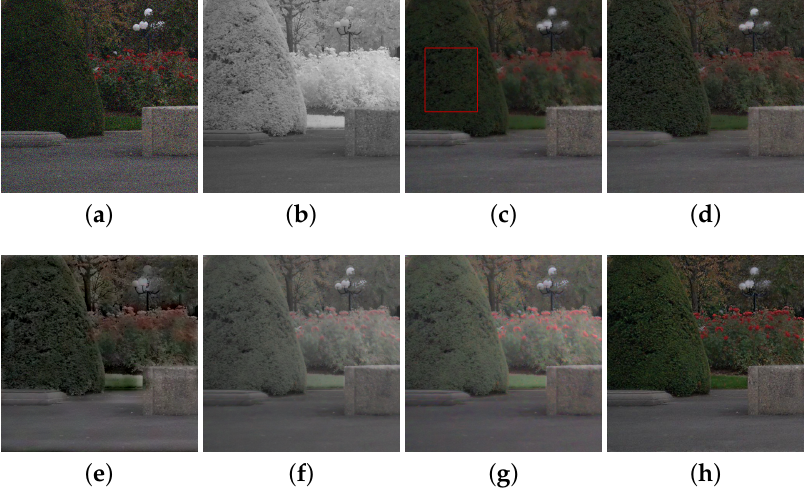
Figure 12. Experimental results for a test image. ( a ) Noisy RGB image. ( b ) NIR image. ( c ) DWLS [11]. ( d ) SM [8]. ( e ) GWS [1]. ( f ) DenseFuse [17]. ( g ) UDIF [20]. ( h ) Proposed